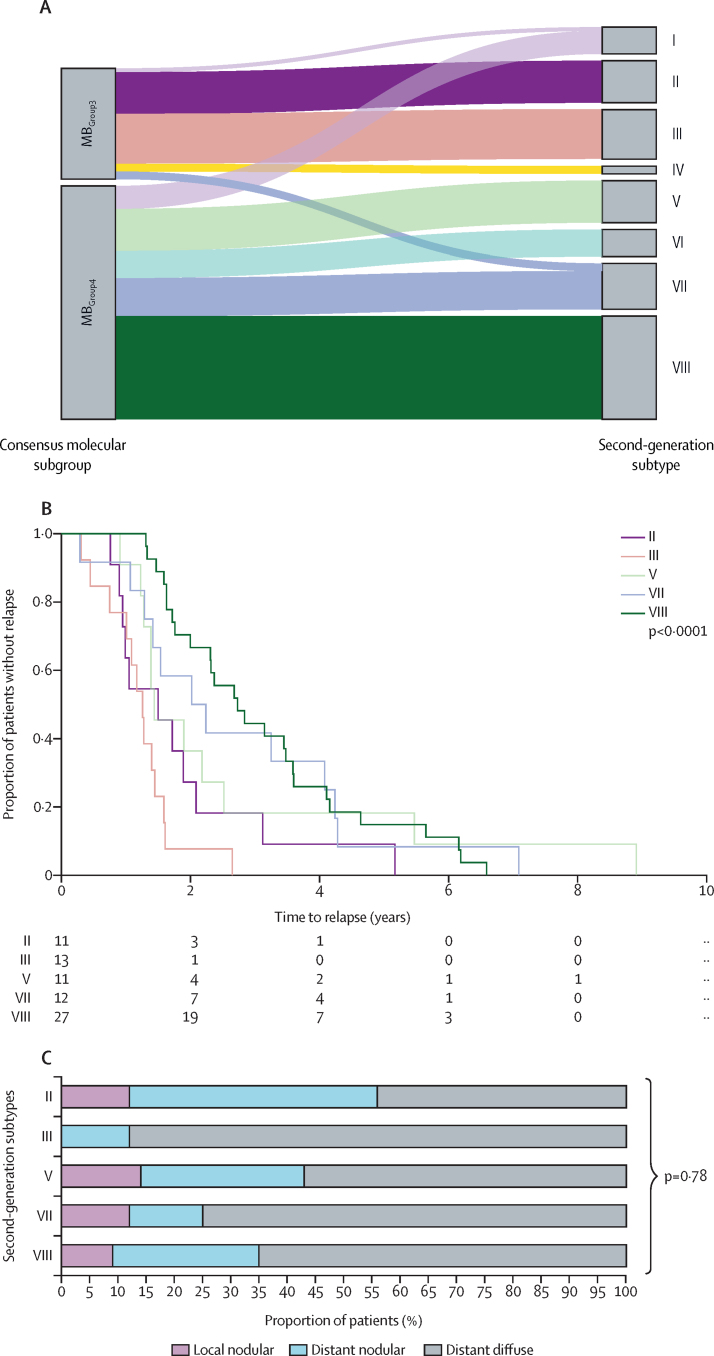
Assessment of relapse characteristics by second-generation MBGroup3 and MBGroup4 subtypes(A) Sankey plot of the relationship between consensus MBGroup3 and MBGroup4 and second-generation subtypes I–VIII. (B) Time to relapse according to second-generation MBGroup3 and MBGroup4 molecular subtype. (C) The different patterns of relapsed disease according to second-generation MBGroup3 and MBGroup4 molecular subtype. Subtype II=9 patients. Subtype III=8 patients. Subtype V=7 patients. Subtype VII=8 patients. Subtype VIII=22 patients. MB=medulloblastoma.